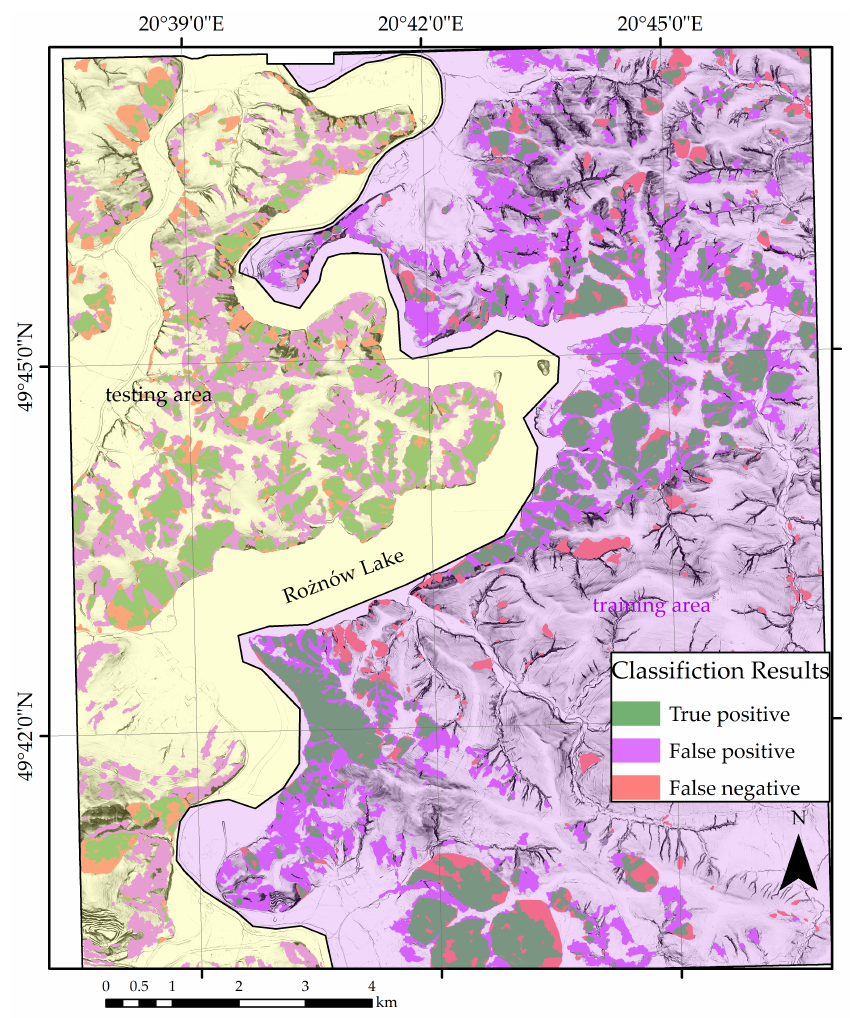
Figure 9. Training and testing area superimposed on the results of the PBA and OBIA joint approach for landslide